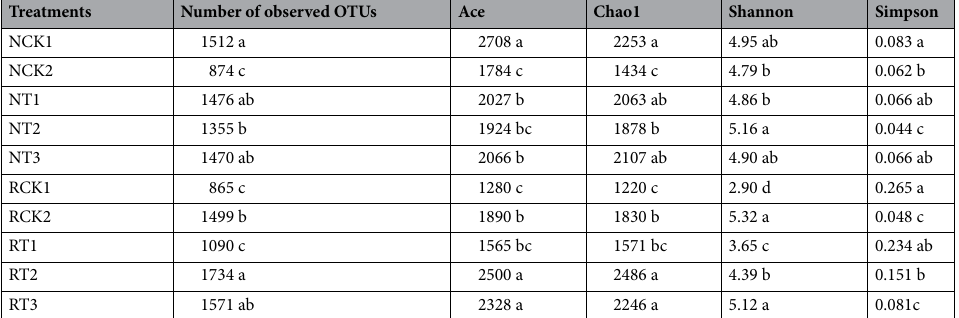
Table 4. Bacterial community abundance and diversity indices of the 16S rRNA gene libraries for clustering at 97% identity in different treatments. RCK1: R-soil in CK1; RCK2: R-soil in CK2; RT1: R-soil in T1; RT2: